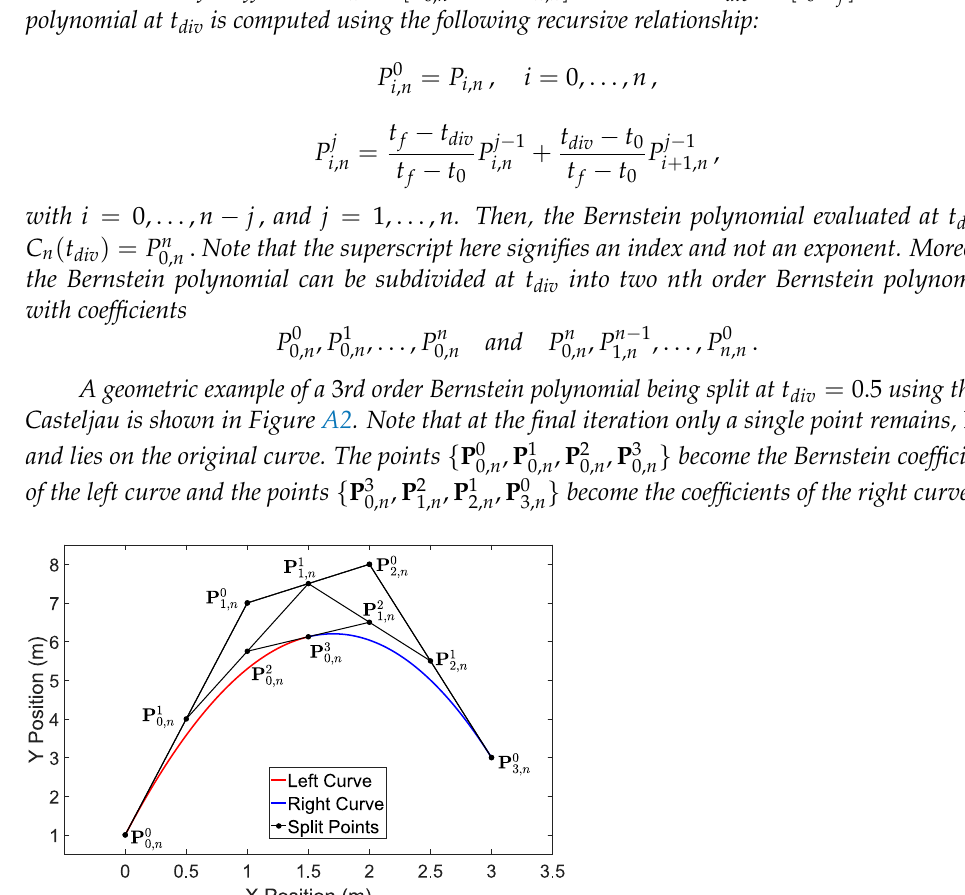
} , the left hand , . . . , P 0 0, n 3, n